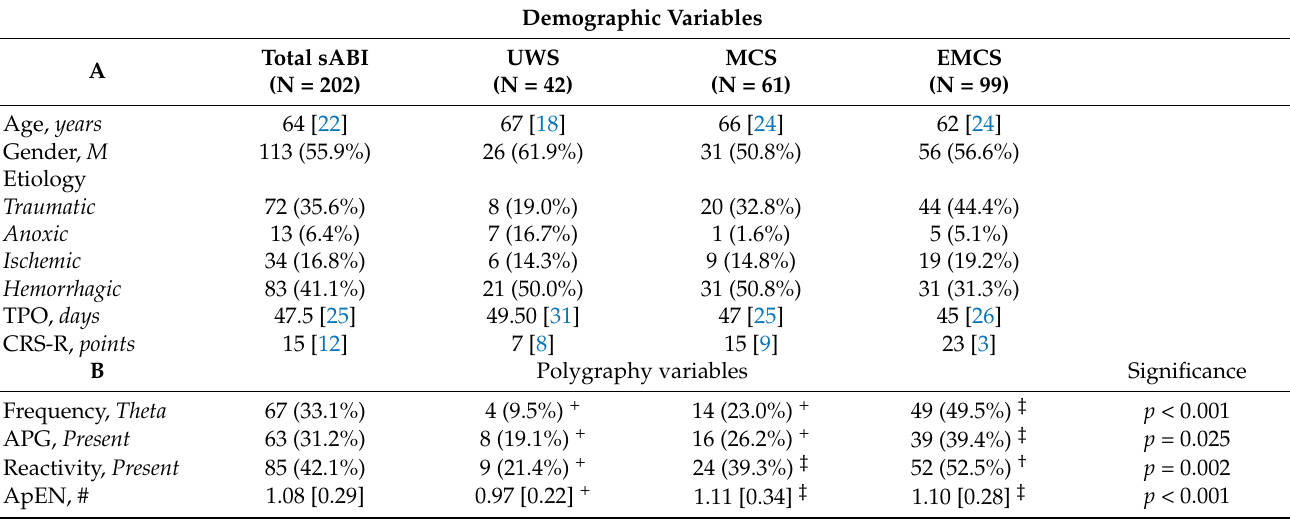
Table 1. Descriptive statistics for the entire cohort and the individual subgroups for demographic vari- ables ( A ) and instrumental variables ( B ). Median and interquartile ranges (in brackets) are reported for numerical independent variables whilst count and percentages (in parentheses) are reported for categorical ones. p -values are reported for chi-square analysis for categorical variables (EEG descriptors) and Kruskal–Wallis test for numerical ones (ApEN). Two columns sharing a subscript ( + , † , ‡ ) are not significantly different (after Bonferroni correction) after the post hoc pairwise